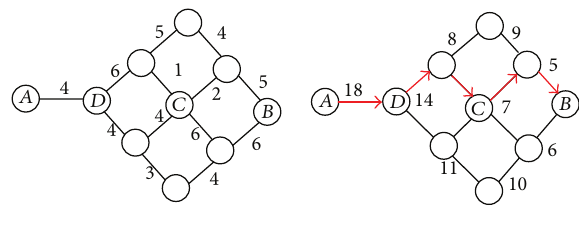
Figure 1: Example of DP.